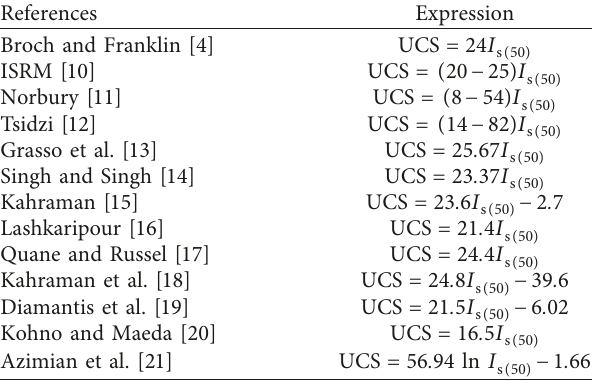
Table 1: Equations correlating the UCS to